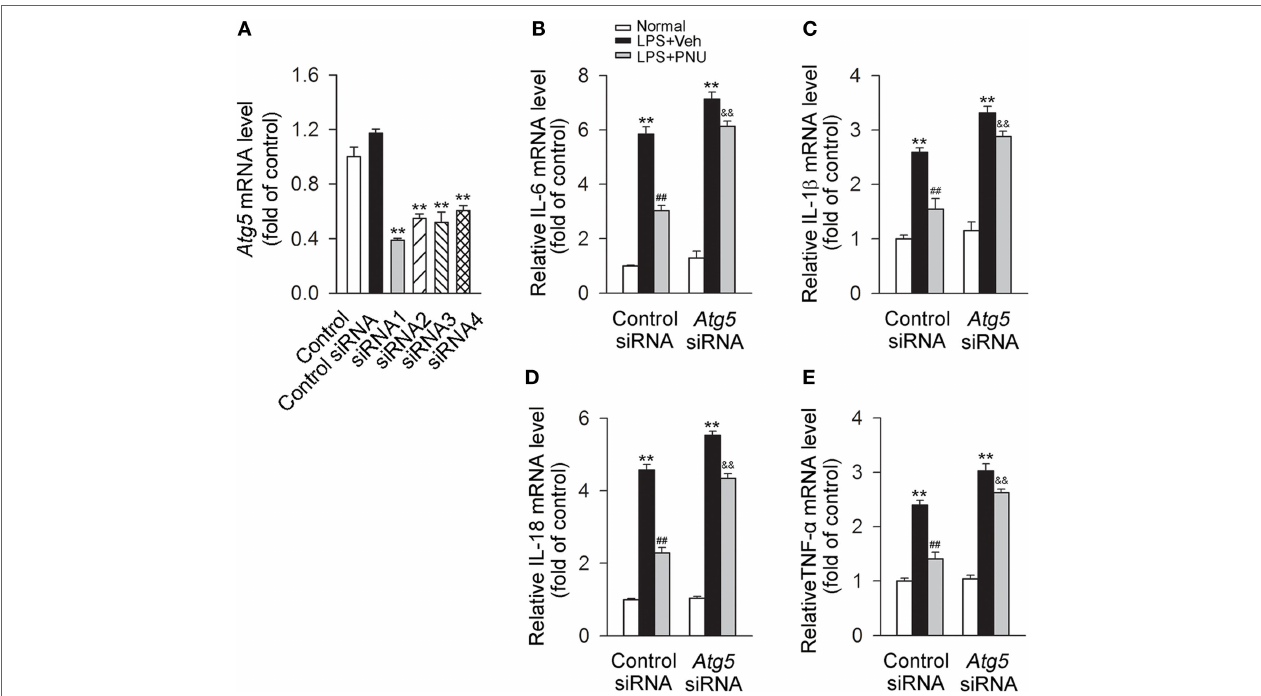
FigUre 7 | Blockade of autophagy by Atg5 sirna greatly attenuates the anti-inflammatory effect of PnU282987 in BV2 microglia stimulated with lipopolysaccharide (lPs) . (a) The quantitative expression of Atg5 mRNA in BV2 microglia after transfection with the control siRNA or Atg5 siRNAs. ** P < 0.01 vs the control siRNA. After transfection with the control siRNA or Atg5 siRNA [ Atg5 siRNA1 according to panel (a) ], BV2 microglia were pretreated with vehicle or PNU282987 (10 µM) and then challenged with LPS (100 ng/ml). The control or Atg5 siRNA were transfected ( n = 6 per group). Production of interleukin-6 (IL-6) (B) , IL-1 β (c) , IL-18 (D) , and tumor necrosis factor- α (TNF- α ) (e) in mRNA level were detected by real-time PCR. The blockade of autophagy process with Atg5 siRNA significantly increased the production of IL-6, IL-1 β , IL-18 and TNF- α in mRNA level ( n = 6 per group). ** P < 0.01 vs normal, ## P < 0.01 vs Veh, && P < 0.01 vs control. Veh, vehicle; PNU,